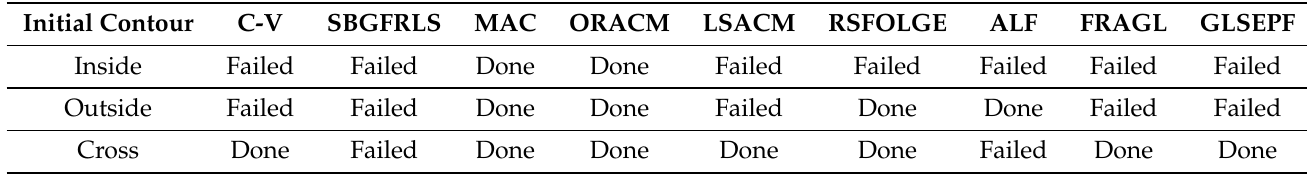
Table 2. Success of active contour methods in obtaining infection area in terms of initial contour.